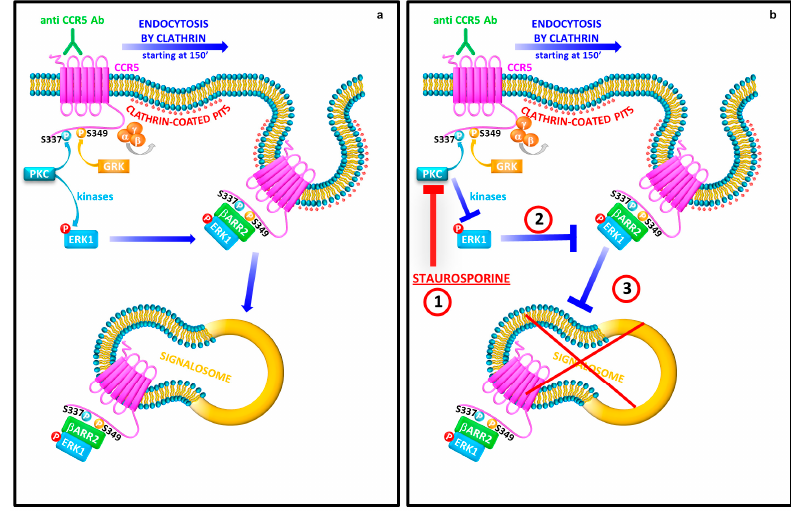
Figure 5. A mechanistic model of CCR5 signalosome formation mediated by CCR5 Ab Pos. CCR5 Ab Pos triggers the receptor phosphorylation GRK-mediated with the recruitment of β -arrestin2. ( a ) Remarkably, β -arrestin2 accumulates in complexes in association with the activated CCR5 and triggers the activation of ERK1, with consequent retention, into the cytosol (150 min); ( b ) the block of the protein kinases phosphorylation mediated by staurosporine treatment (1), which in turn has an effect on both CCR5 and ERK1 (2), resulting in the abolition of the accumulation of CCR5 into the early endosome after binding with CCR5 Ab Pos